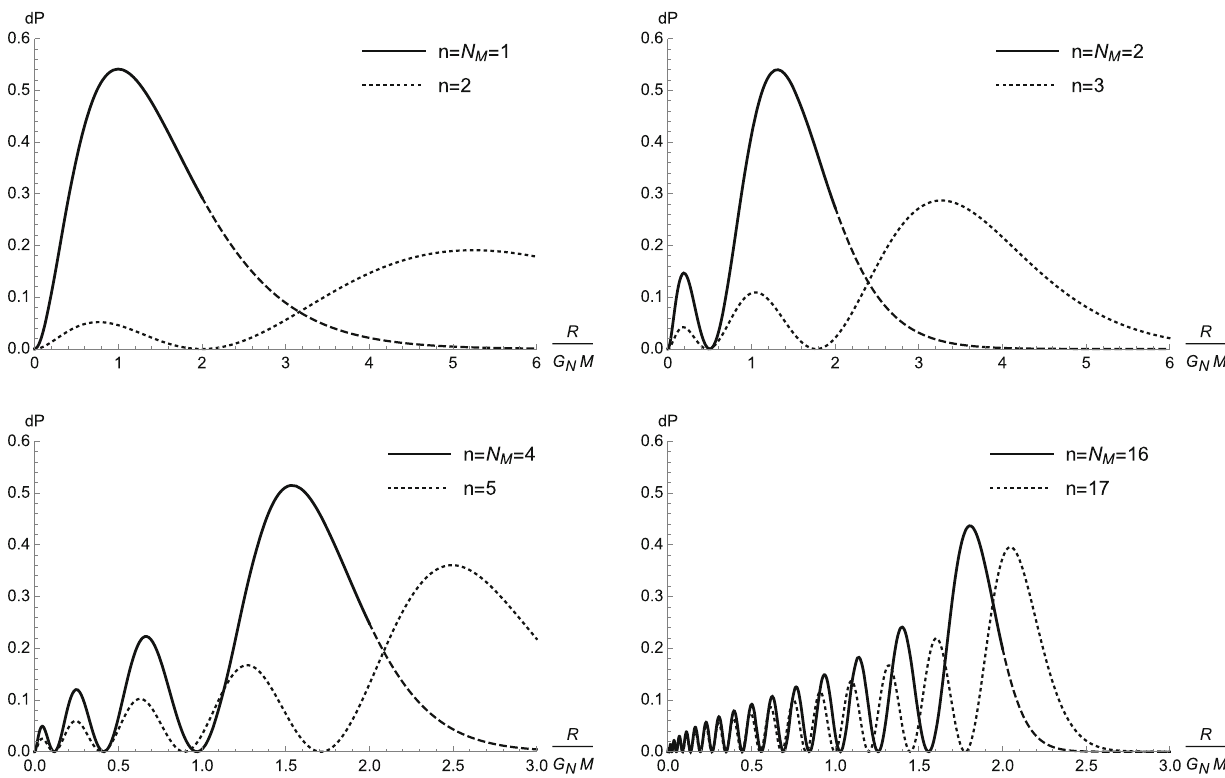
Fig. 1 Probability density P = P ( R ) for: ( a ) ground state with n = N M = M 2 / m p2 [solid (dashed) line represents the region inside (outside) the gravitational radius R H = 2 G N M ]; ( b ) first excited state with n = N M + 1 (dotted